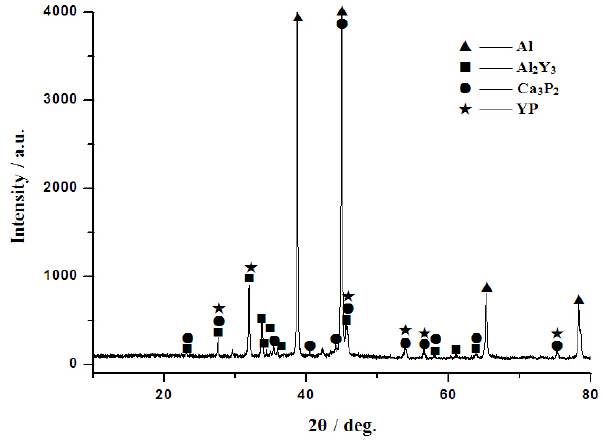
Figure 3. X-ray diffraction (XRD) patterns of Al–2Ca–3Y–1P alloy.